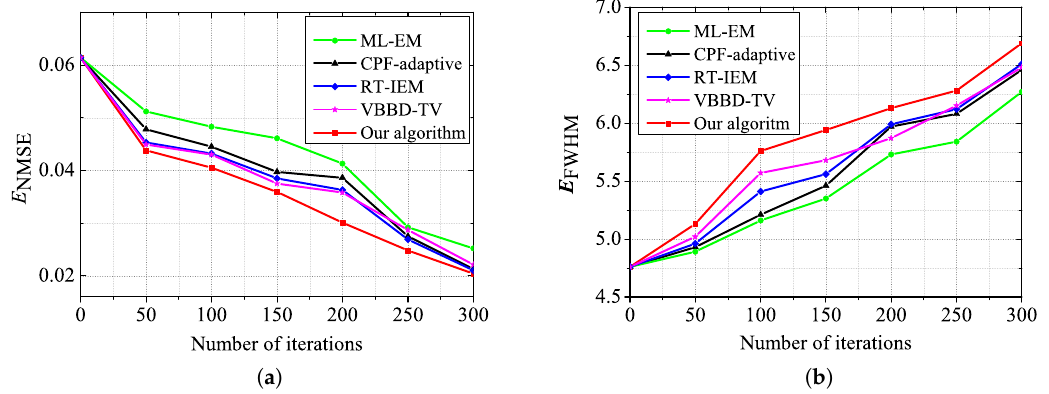
Figure 5. The restoration comparisons on E NMSE and E FWHM measures versus the iteration number for the five methods. ( a ) E NMSE versus the iteration number of the five algorithms; ( b ) E FWHM versus the iteration number of the five